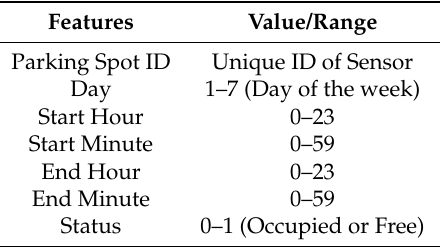
Table 1. Extracted